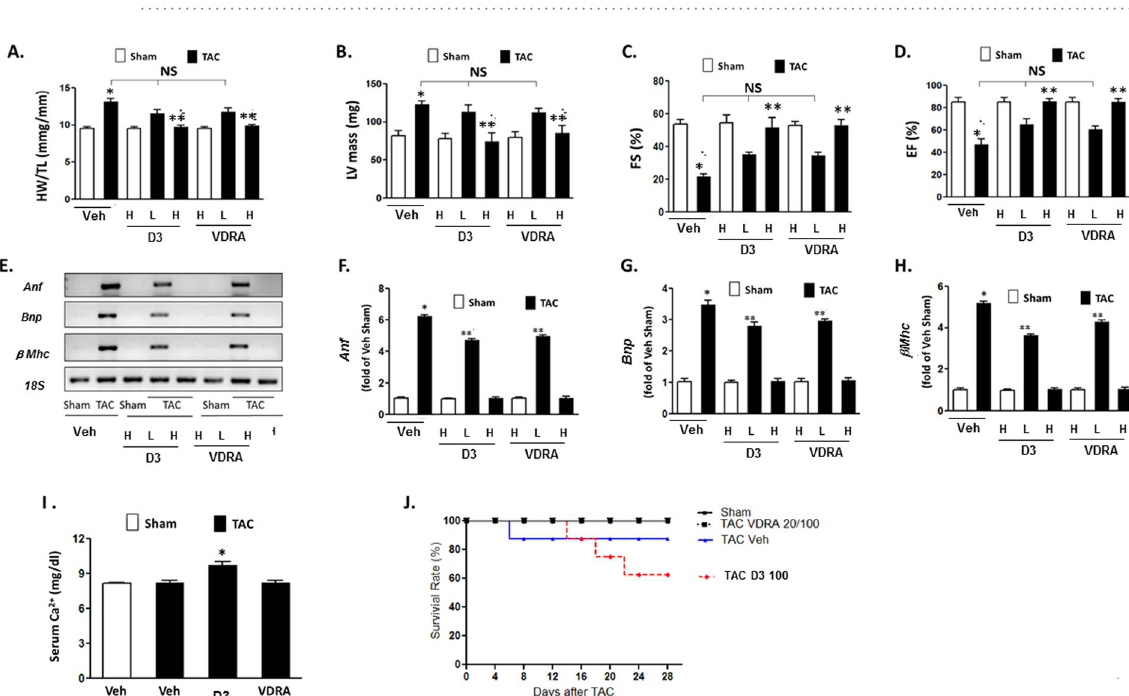
Figure 6. Effect of physiologic dose of VDR 4-1 (0.6 μμ g/kg) on vitamin D deficient mice after TAC in vivo . ( A–D ) Morphologic and functional assessment of 1 α -HO KO mice at 4 weeks after TAC. HW/BW ratio ( A ) LV mass ( B ) Fractional shortening ( C ) and ejection fraction ( D ) are displayed. * p < 0.05 vs Veh-Sham, ** p < 0.05 vs Veh-TAC; N = 4–6. ( E ) Representative Anf , Bnp and μ Mhc mRNA expression. Only relevant PCR bands are shown. No alteration was done to the original gel images. 18 S was used as an internal control for RNA. ( F–H ) Quantification of Anf ( F ), Bnp ( G ), and μ Mhc ( H ) mRNA expression. D3 = 1,25-D 3 (0.6 μ g/kg), VDR = VDR 4-1 (0.6 μ g/kg) 3 x/week i.p . Total volume injected = 50 μ L/animal/injection. * p < 0.05 vs Veh-Sham, ** p < 0.05 vs Veh-TAC; N = 4–6.